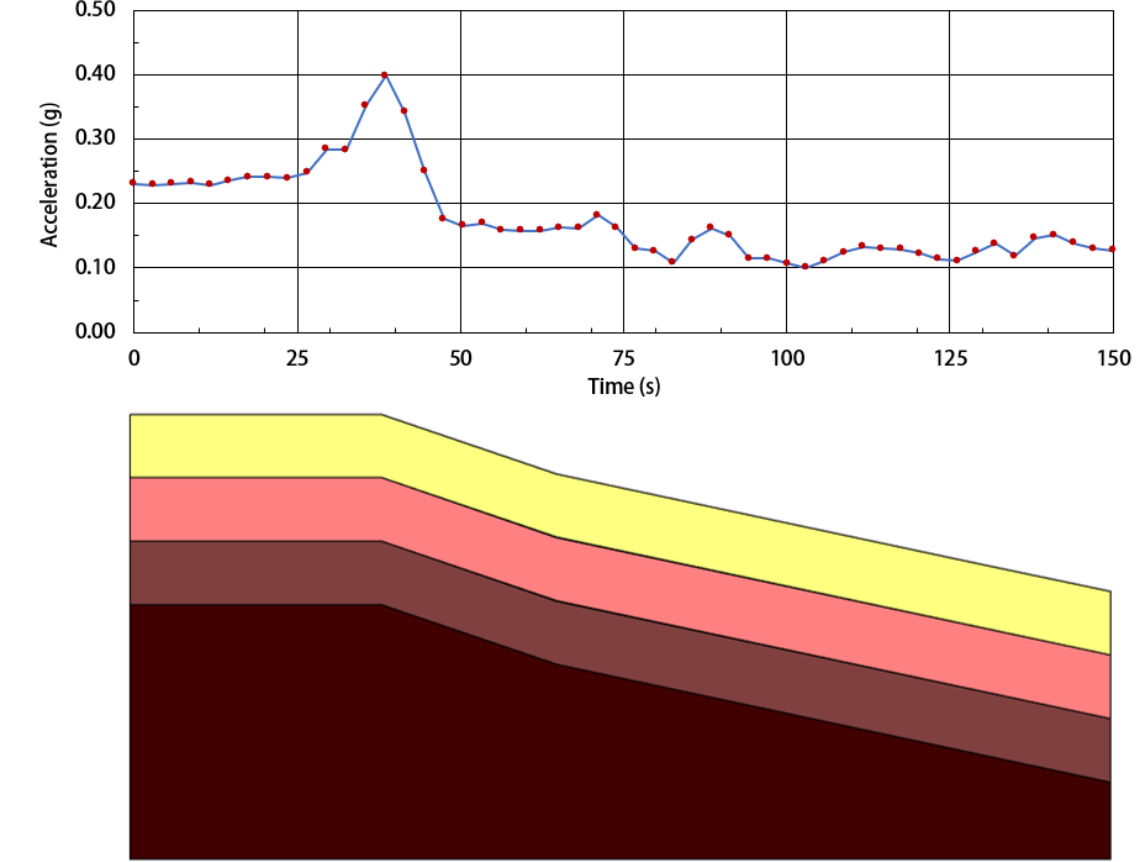
Figure 16. Surface acceleration profile along the 2-D section analyzed through QUAKE/W code for the Amoruso et al. [26] input.